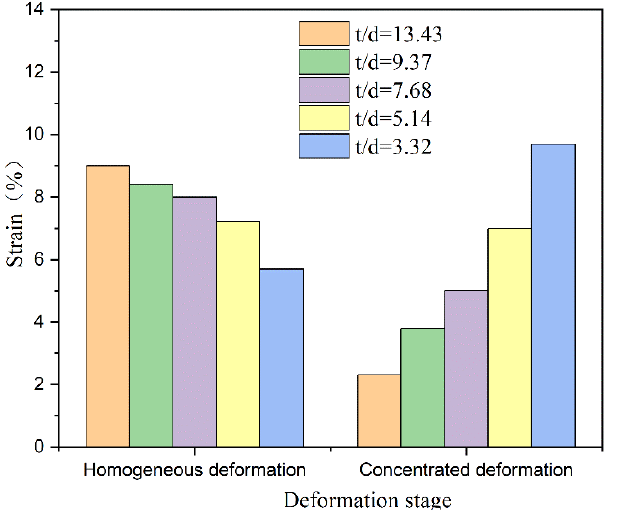
Figure 6. The homogeneous deformation and the concentrated deformation of various Ti ‐ 2.5Al ‐ 1.5Mn foils.